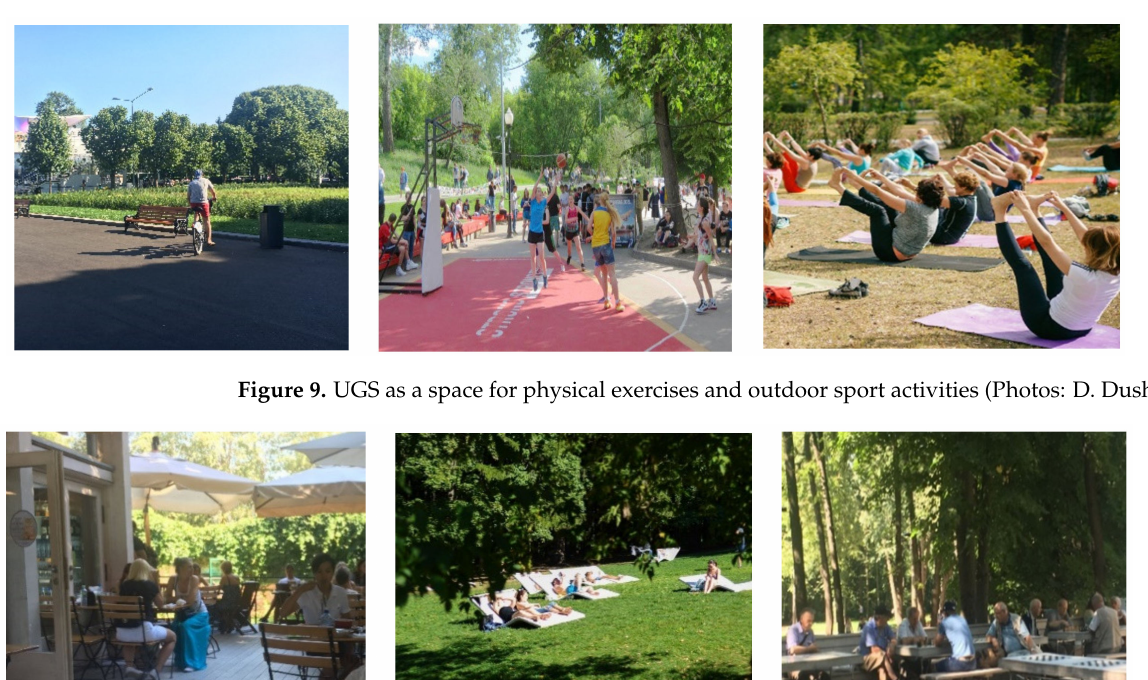
Figure 8. UGS for spending time with family and children (Photos: D. Dushkova).